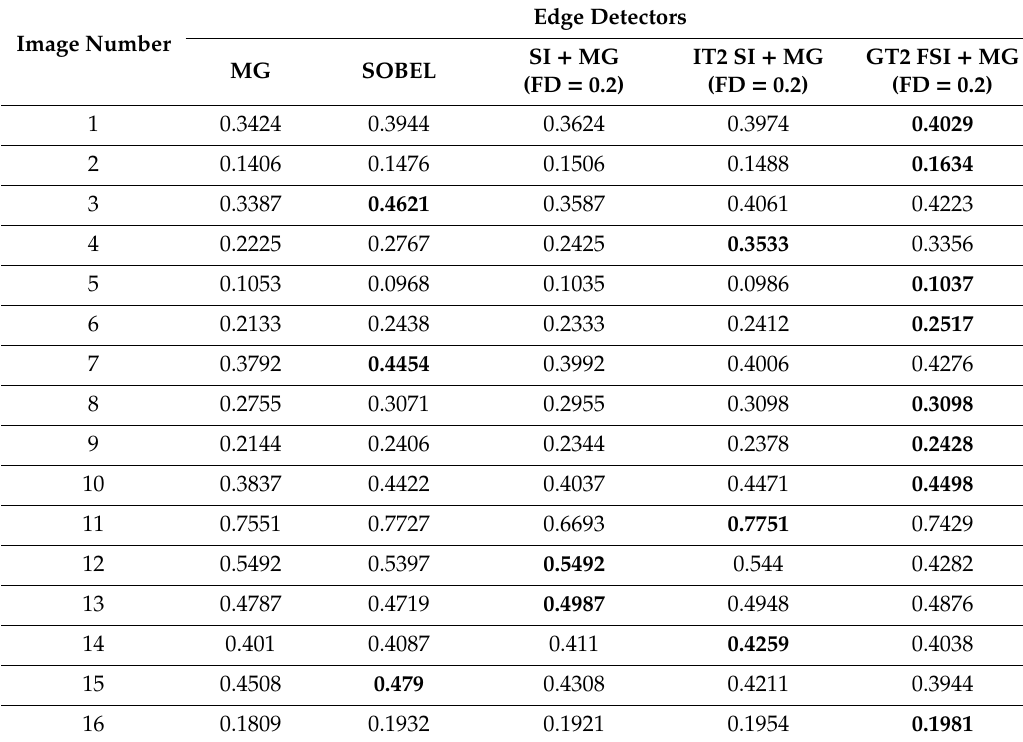
Table 12. FOM metric obtained after using edge detectors in the BSDS